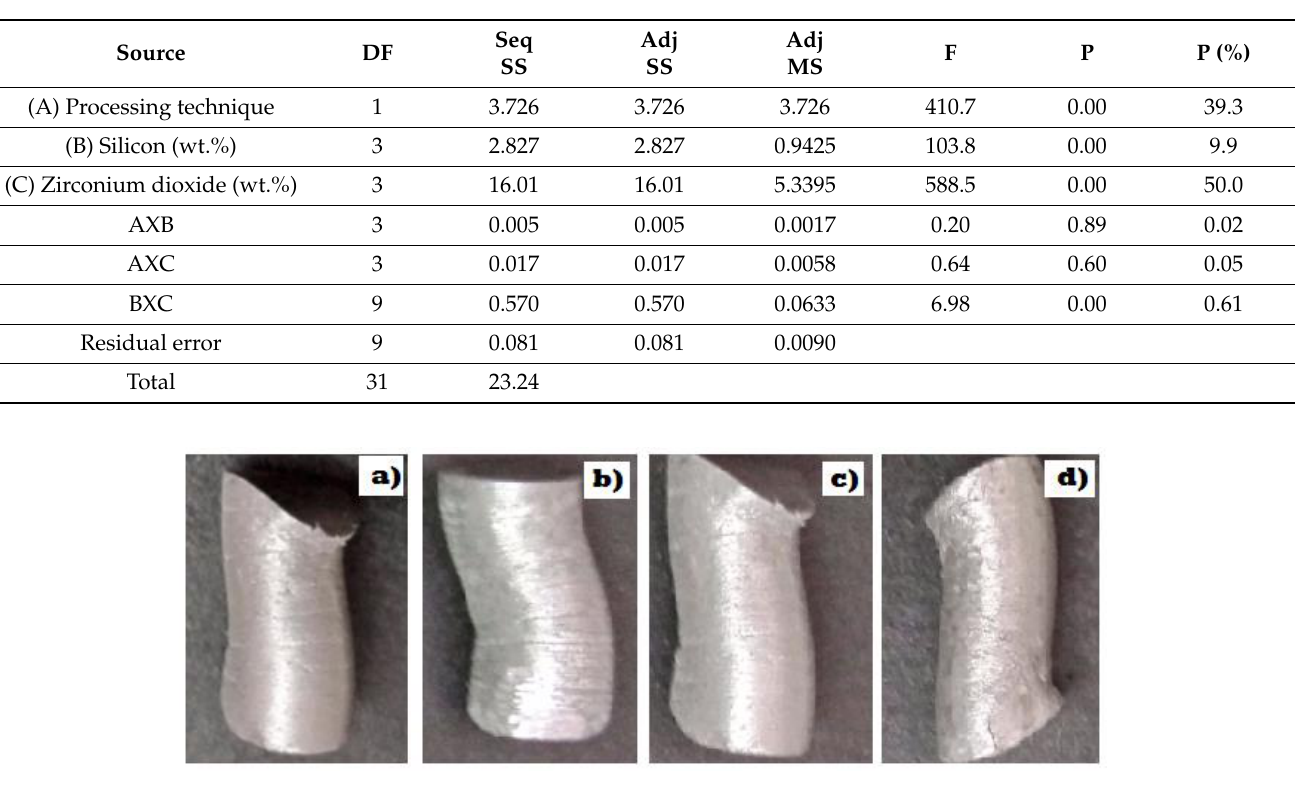
Figure 17. Main effects plot for ( a ) means and ( b ) SN ratio for compressive strength.